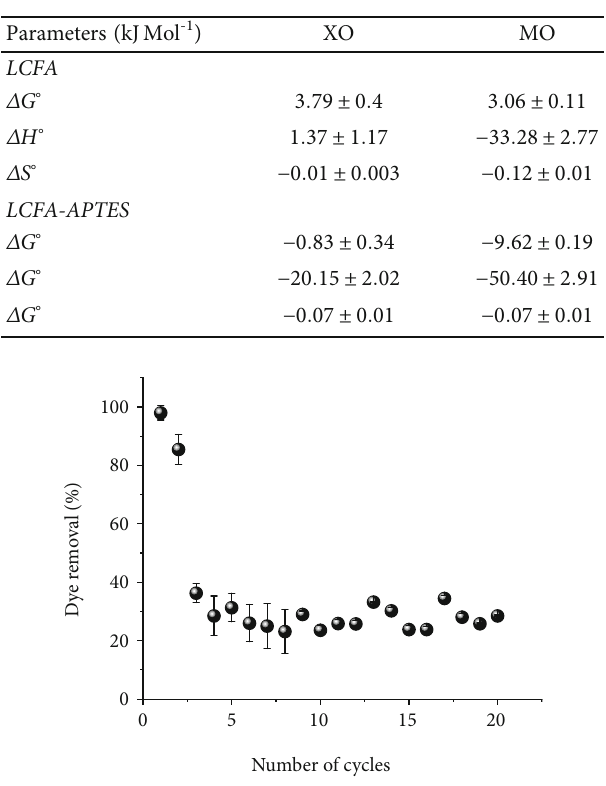
Figure 9: Reusability of LCFA-APTES for the adsorption of MO ( pH = 4 for adsorption and pH = 12 for desorption, T = 25 ° C , t = 5 min , amountof adsorbent = 10mg ). The error bars represent the standard deviation of at least three repeated measurements for each